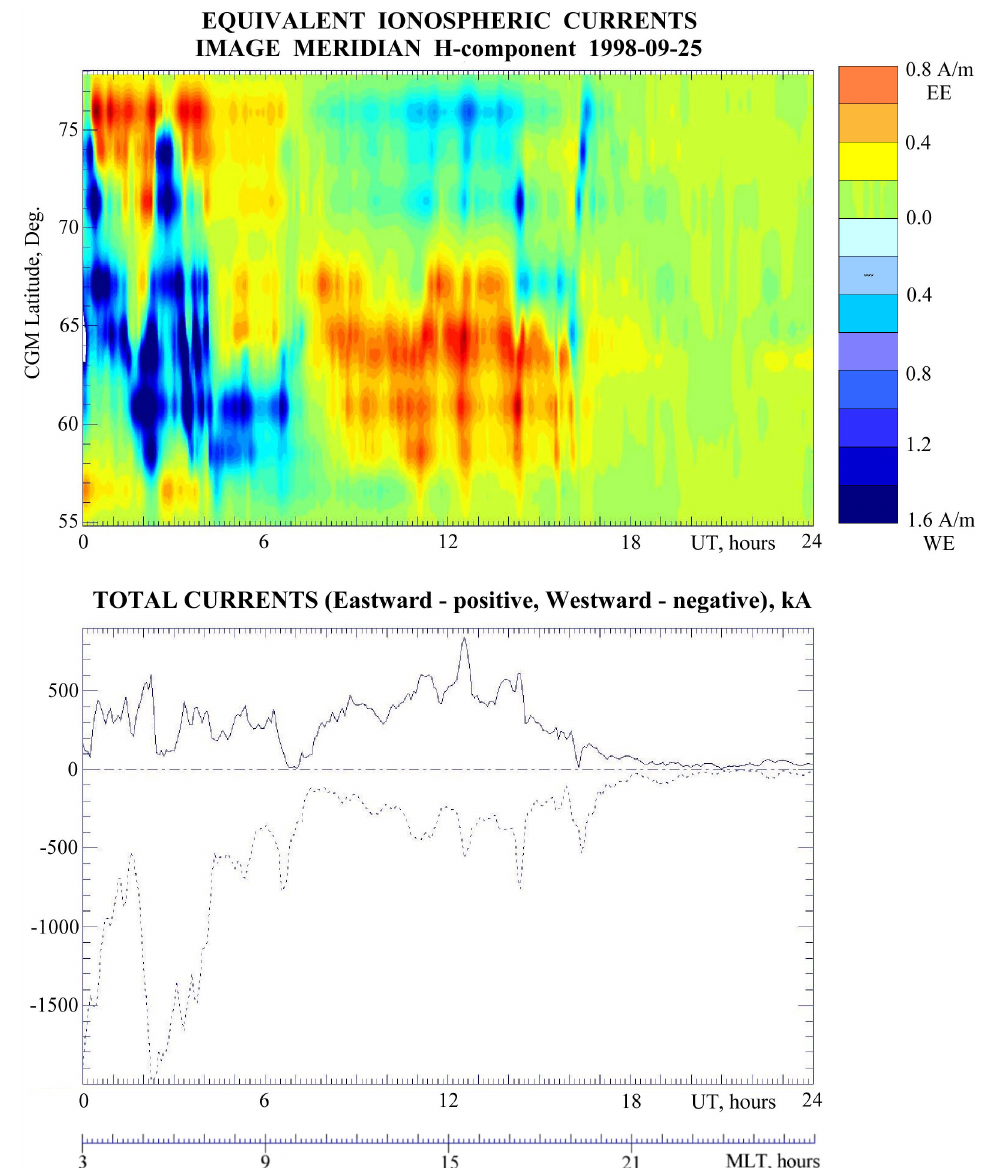
Fig. 3. As Fig. 2, but on 25 September 1998 for the IMAGE meridian chain of magnetic